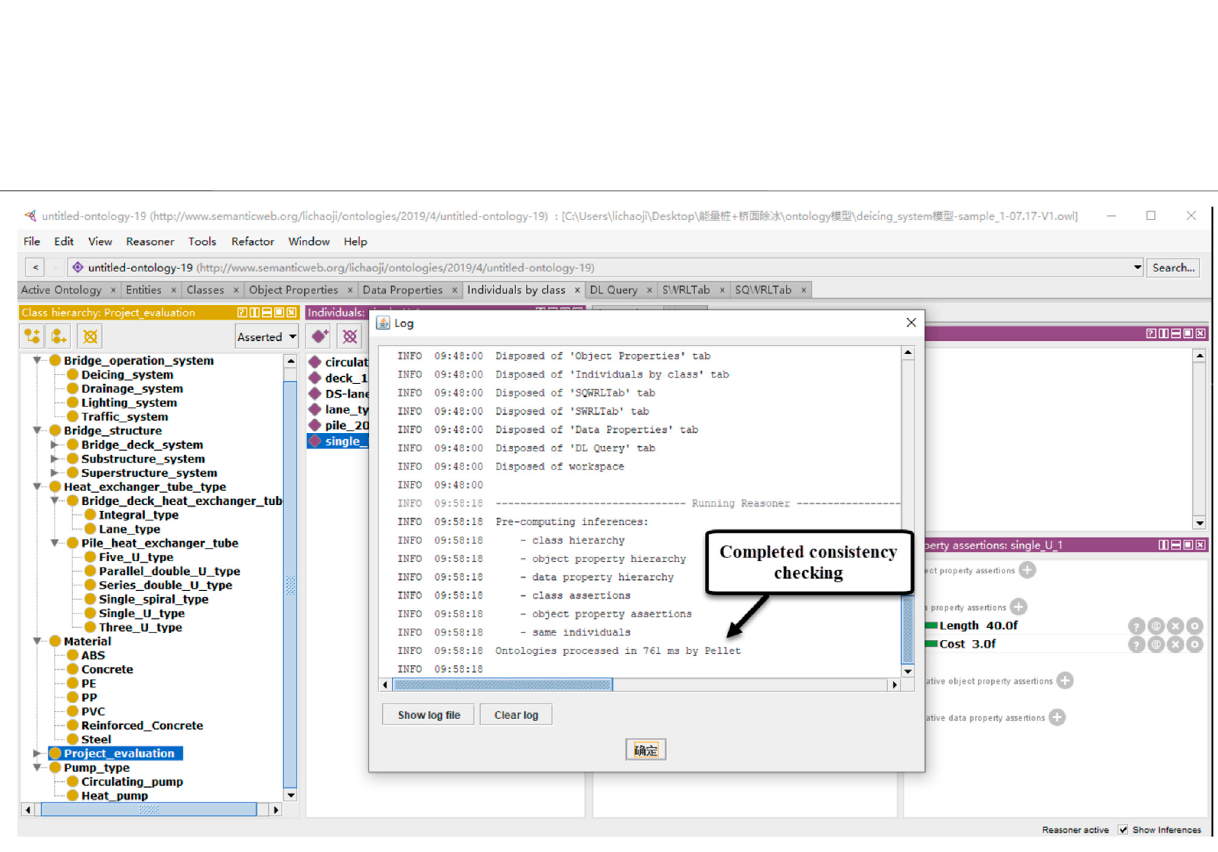
Frontiers in Materials |